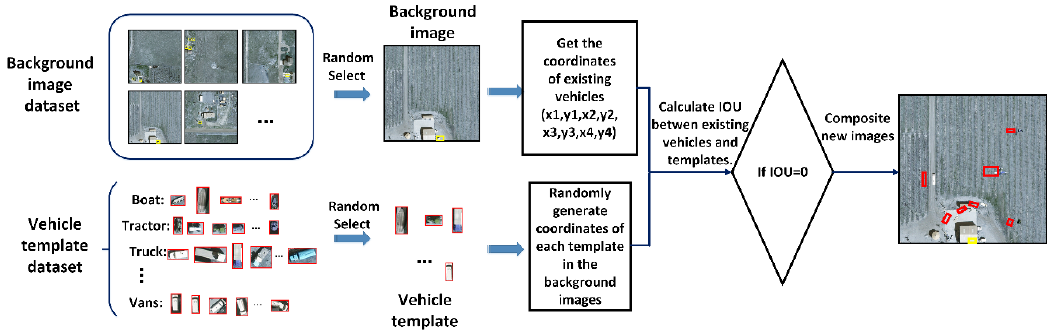
Figure 4. Schematic of oversampling and stitching data augmentation for foreground-foreground class imbalance problem.